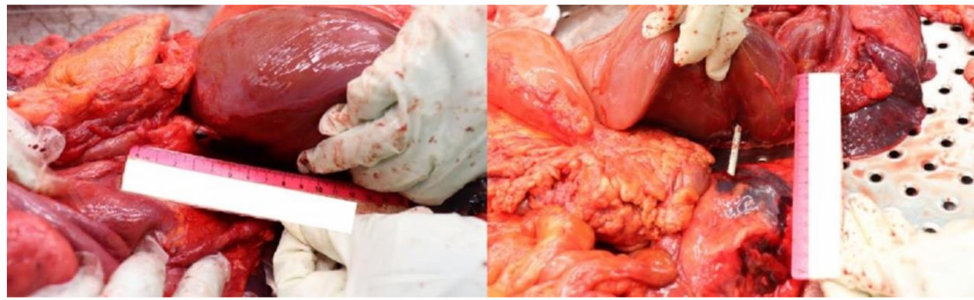
Figure 4. A completely intact diaphragm: a very rare necropsy finding in a thoracoabdominal GSW.